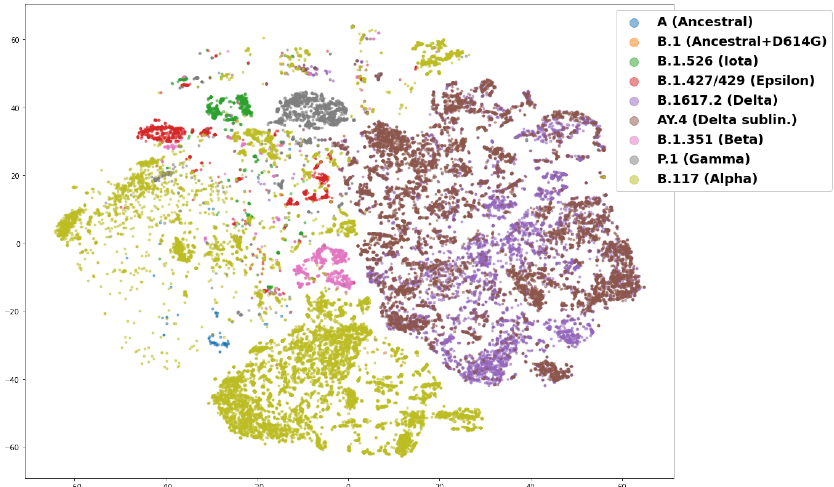
Figure 2. Plot of a two-component t-SNE analysis (with perplexity of 50) for the 64-dimensional embeddings of raw spike protein sequence data following a prediction task for the date of first sample collection (in days since 1 December 2019) of a particular sequence. The training data consisted of sequences found 4 or more times in the global data set (all spike protein sequences available on GISAID as of 1 October 2021), and the validation data shown here consists only of raw, unprocessed spike sequences found 2 or 3 times in the global data set. The lineages shown in this plot are provided in the legend and consist of the ancestral lineage (A), as well as variants of concern and interest including Alpha (B.1.1.7), Beta (B.1.35.1), Iota (B.1.526), Gamma (P.1), Epsilon (B.1.427/429) and Delta (B.1.617.2), and AY.4, a Delta sublineage. Many lineages can be clustered with the embeddings; Delta and the AY.4 Delta sublineages cluster into a large but well separated group, while Alpha is spread out.